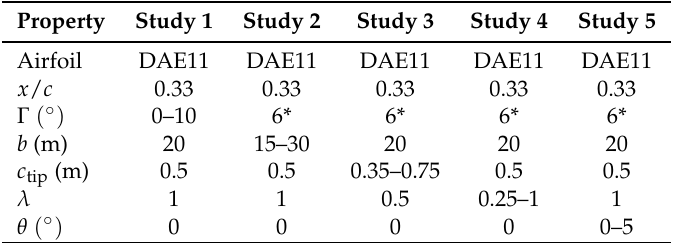
Table 7. Overview of the sensitivity studies. An asterisk * indicates the desired value during flight.